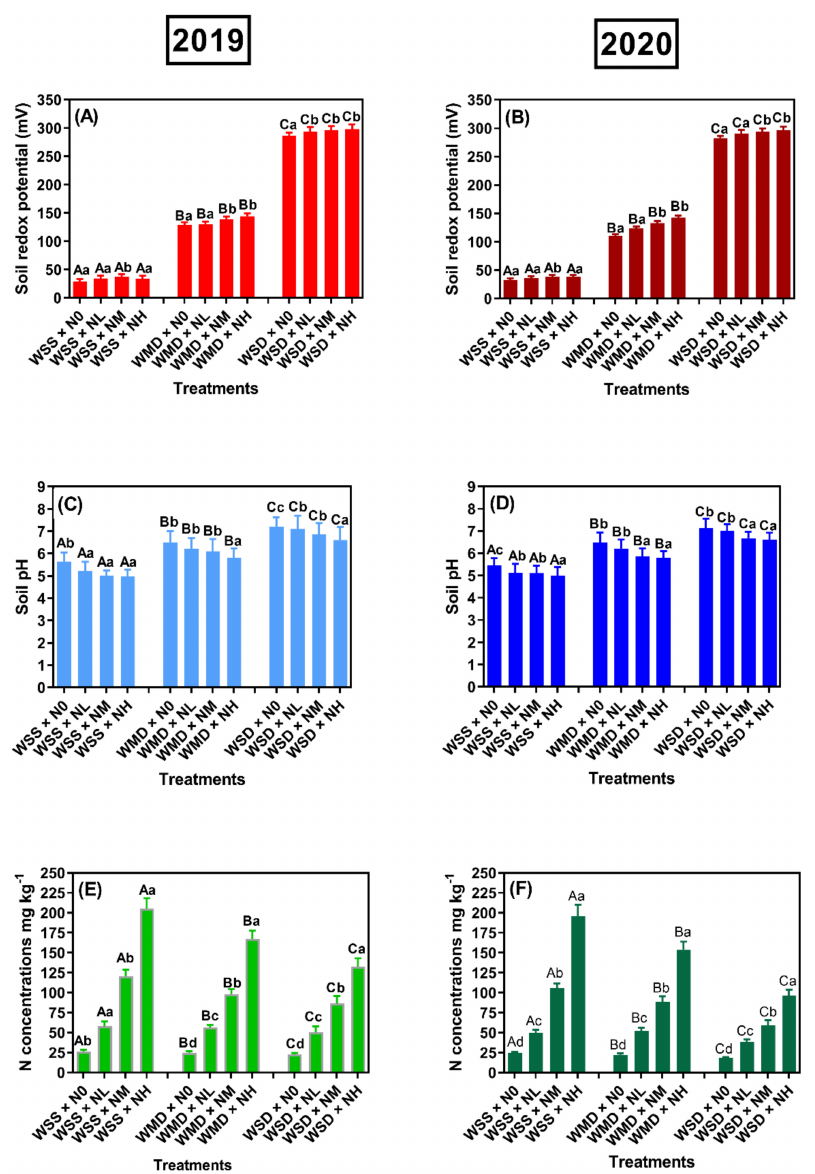
Figure 3. Effects of SRNF S rates and water regimes on soil fertility in the root zone. ( A , B ) repre- sent the soil redox potential in 2019 and 2020 respectively. ( C , D ) represent the soil pH in 2019 and 2020 respectively. ( E , F ) represent the soil N concentration in 2019 and 2020 respectively. WSS, WMD, and WSD donate wetting and saturation, wetting and moderate drying, and wet- ting and severe drying, respectively. N0, NL, NM, and NH donate without adding SRNF S , light SRNF S , moderate SRNF S , and heavy SRNF S , respectively. Means are not significantly